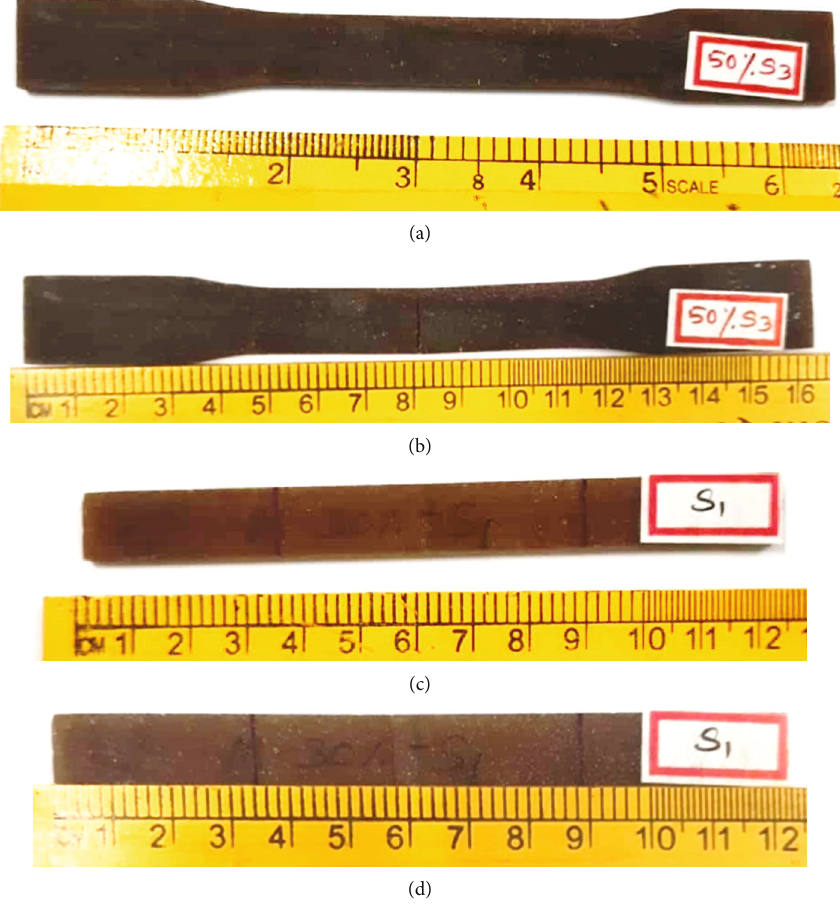
Figure 5: (a) Tensile specimen before testing. (b) Tensile specimen after testing. (c) Flexural specimen before testing. (d) Flexural specimen after testing.